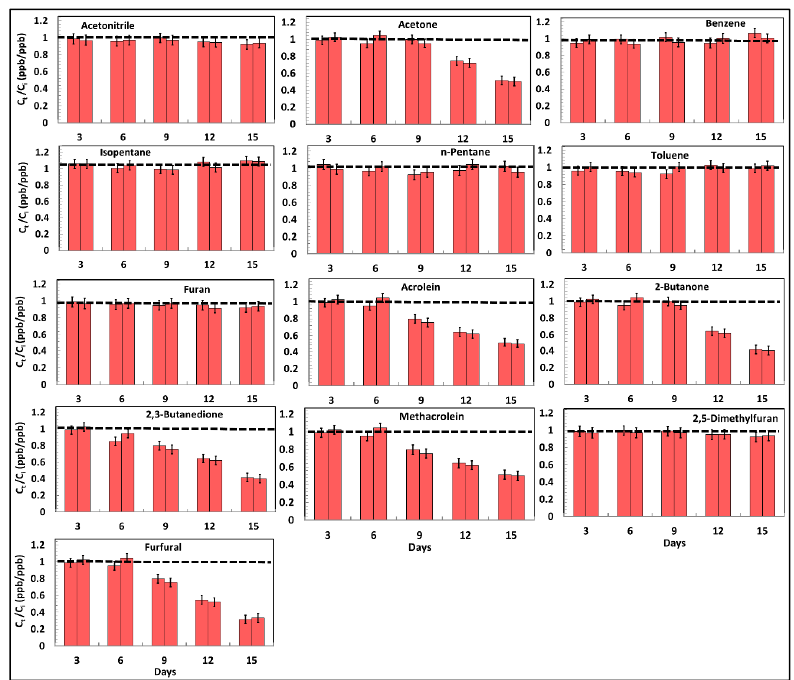
Figure 4. Stability of VOCs over the storage of 15 days inside the dual-bed Carboxen-Graphsphere TD tubes sampled using wood smoke. Histograms in each VOC plot correspond to the ratio of VOC concentration measured after “t” days of storage (C t (ppb)) to the initially measured averaged concentration of VOC on day 0 (C i (ppb)). Error bars on each histogram correspond to 1 σ precision error when measuring the VOCs from the two TD tubes analyzed every 3 days.